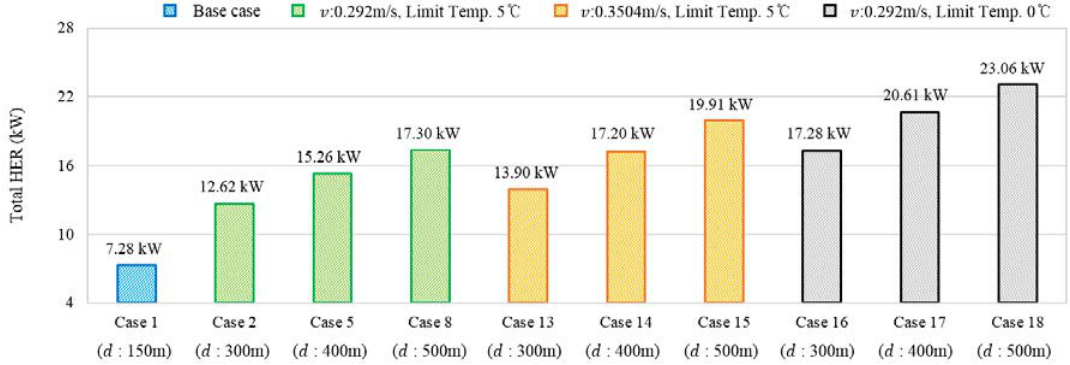
Figure 12. Total HER per borehole according to the operation method and the length of the GHX.